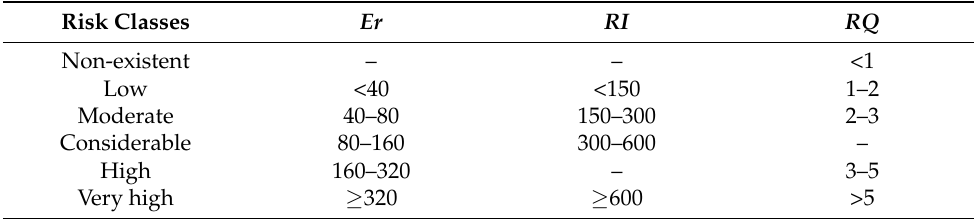
Table 3. Criteria for classifying ecological risk on the basis of potential ecological risk factor ( Er ), potential ecological risk index ( RI ) [49], and risk quotient ( RQ )